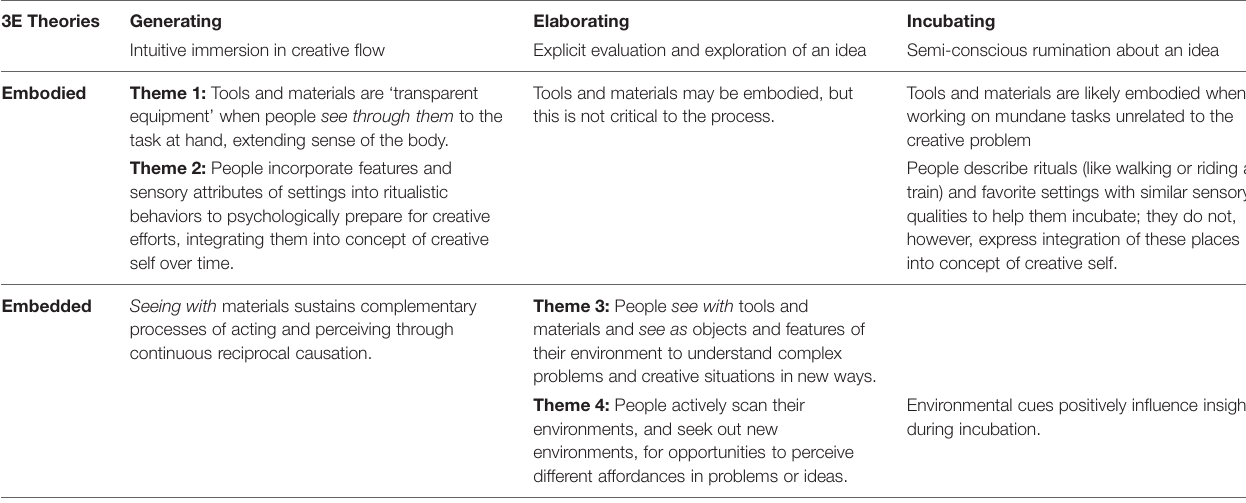
TABLE 2 | The 3E’s and modes of creative ideation: summary of